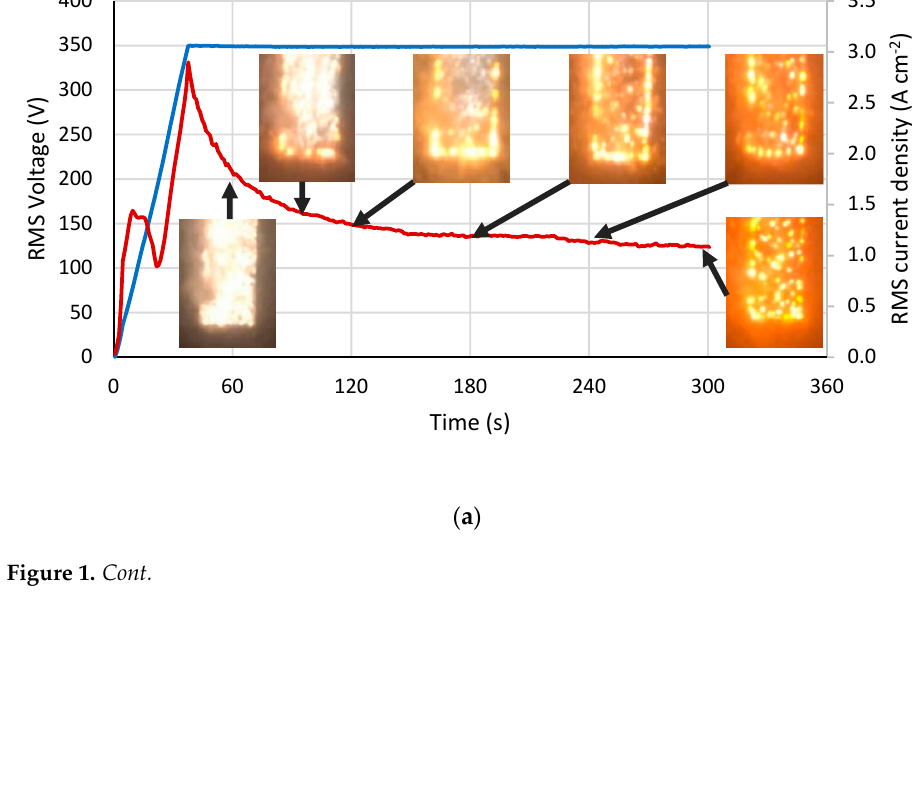
( b ) Figure 1. Evolution of RMS values of the voltage (blue) and current density (red), and microdis- charges during the PEO process: ( a ) during all the treatment time; ( b ) during the initial stage of the process. 3.2. Evolution of Surface Morphology and Phase Composition during PEO of Ti The PEO coating morphology in top view and in cross-sections at each duration of interest is shown in Figures 2 and 3. Starting from 45 s, the coating showed a porous mor- phology. The pore size distribution is depicted in Figures 2 and 3 for each image; the most numerous pores had diameters under 1 µm. The most rapid growth of the coating oc- curred during the first 120 s of the process (Figure 2). Furthermore, the growth rate de- creased, and the coating became larger through the pores and a network of cracks could be seen in the cross-sections. Figure 4 demonstrates the evolution of the PEO coating phase composition with the treatment time. The XRD revealed the peaks belonging to the Ti substrate, and two phase modifications of titania: anatase and rutile. Thinner coating at 45–60 s showed predomi- nantly anatase peaks (101 at 25.325 deg. 2 θ ). Rutile peaks (110 at 27.434 deg. 2 θ ) gradually